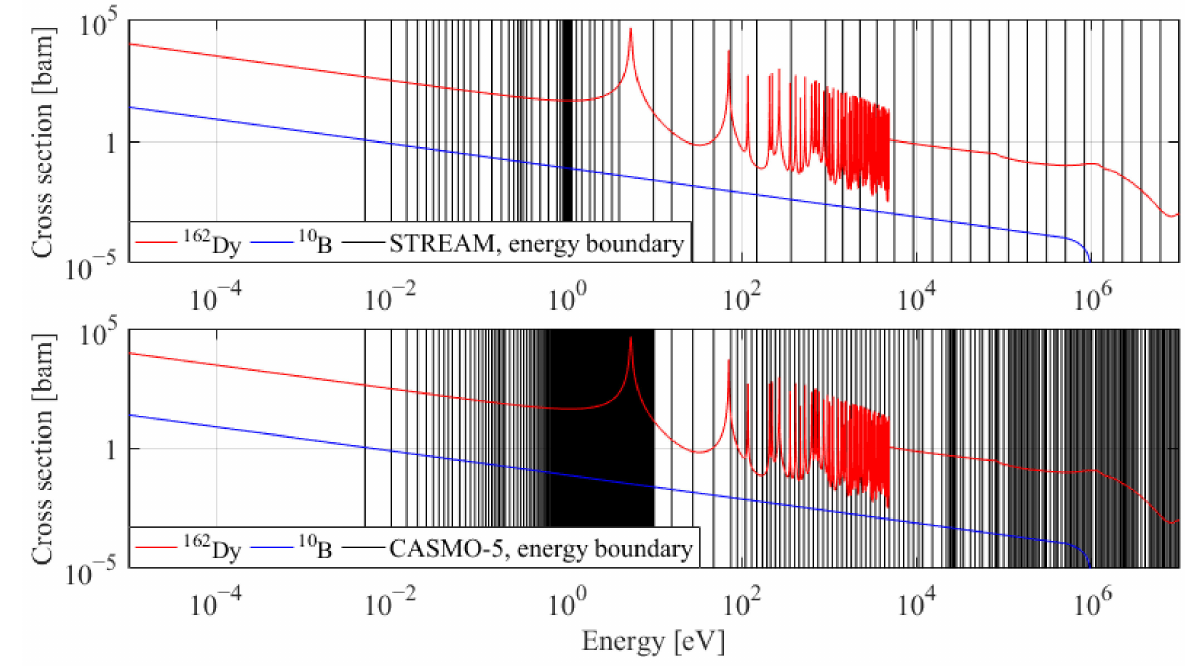
Figure 12. Capture cross section of 162 Dy and 10